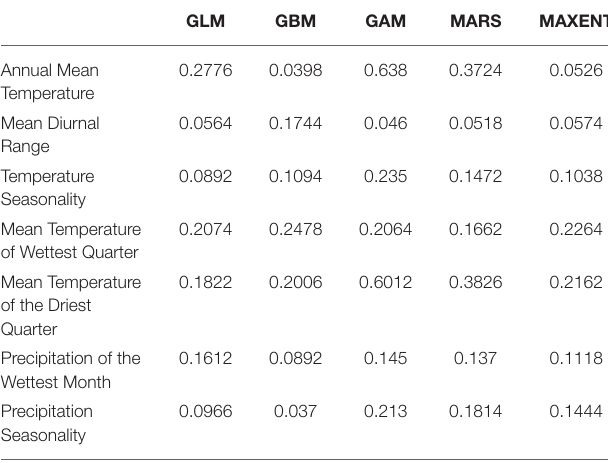
TABLE 2 | Variable importance for the different